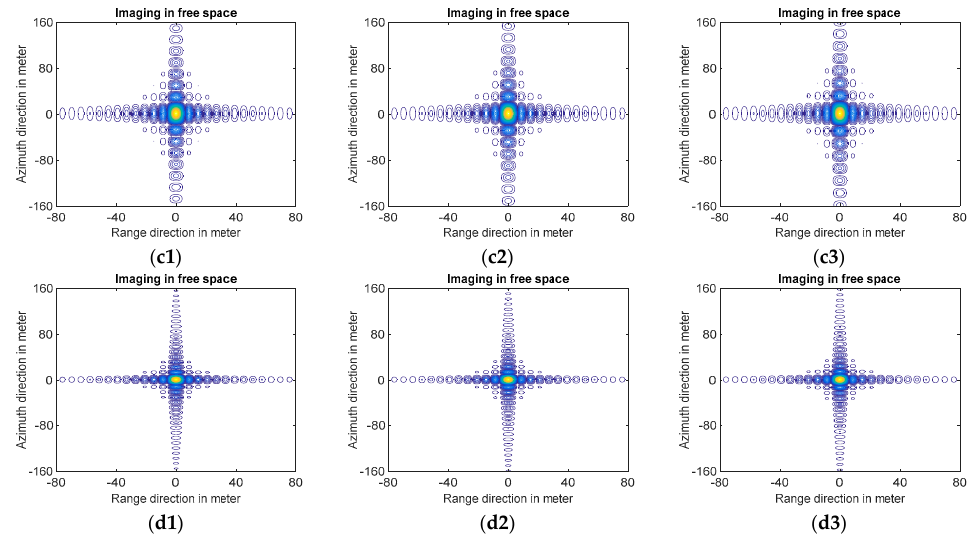
Figure 15. Comparison of azimuthal imaging with different positions, where the 1st (a1,b1,c1,d1), 2nd (a2,b2,c2,d2), and 3rd (a3,b3,c3,d3) columns show declination angle of 18 degrees, 22 degrees, and 28 degrees, respectively. The first row signifies a latitude of 0 degrees, with no difference between the ascension and longitude. The second row denotes a latitude of 0 degrees, with a difference of 30 degrees between the ascension and longitude. The 3rd row and 4th row show the case of latitude of 40 degrees and 70 degrees, respectively, both with no difference between ascension and longitude.